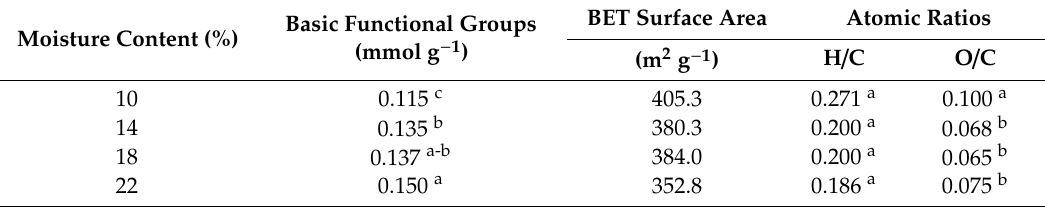
Table 3. Atomic ratios and basic functional groups of biochar from pine woodchips produced at varying biomass moisture contents. BET: Brunauer-Emmett-Teller.